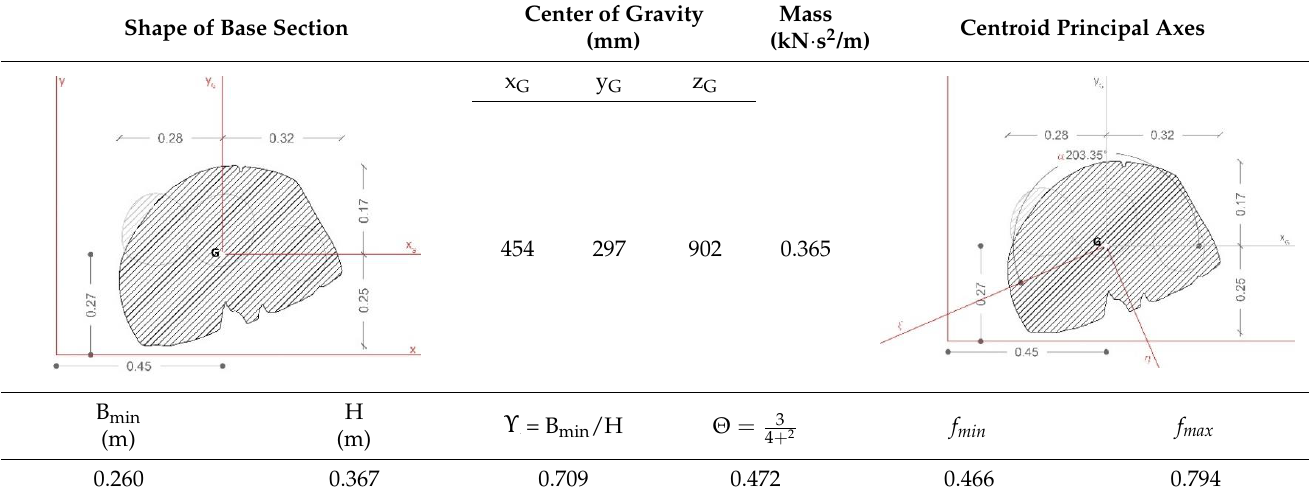
Table 4. Summary of the main geometric features of the asset for seismic rigid block analyses.